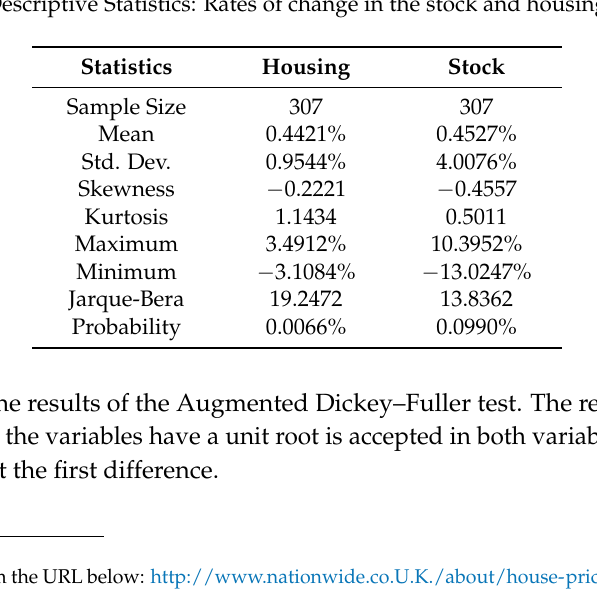
Figure 2. Rates of change in the stock and housing indexes. Data Source : Nationwide Building Society, Yahoo Finance. Table 2. Descriptive Statistics: Rates of change in the stock and housing